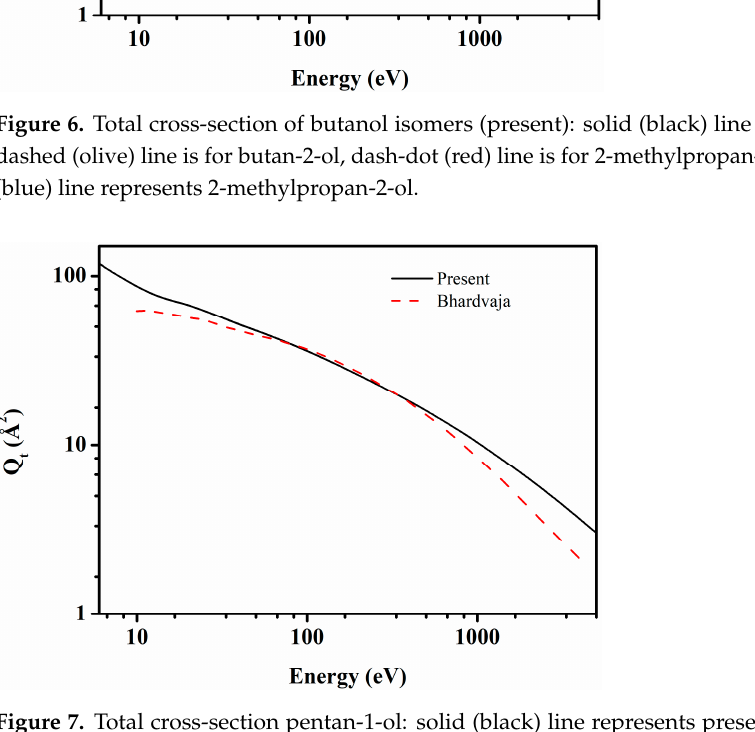
Figure 7. Total cross-section pentan-1-ol: solid (black) line represents present results and dashed (red) line represents results by Bhardvaja et al.